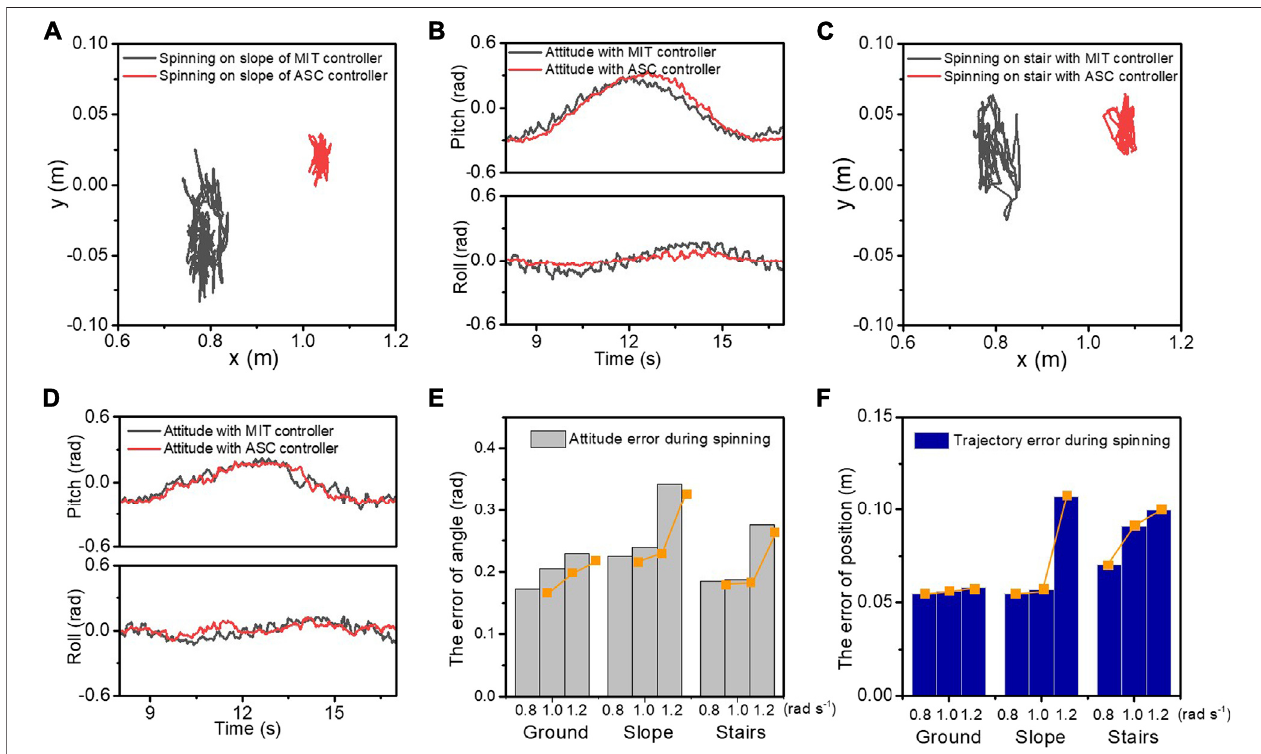
FIGURE 10 | The CoM trajectory, the roll and pitch angles, the displacement, and velocity of the x and y axes in the experiment of spinning on the slope (A, B) and stairs (C, D) . The black and red lines represent the experimental data with the MIT controller and our ASC controller, respectively. The statistical attitude errors (E) and trajectory errors (F) are recorded when spinning on different terrains with varied velocities of 0.8, 1.0, and 1.2